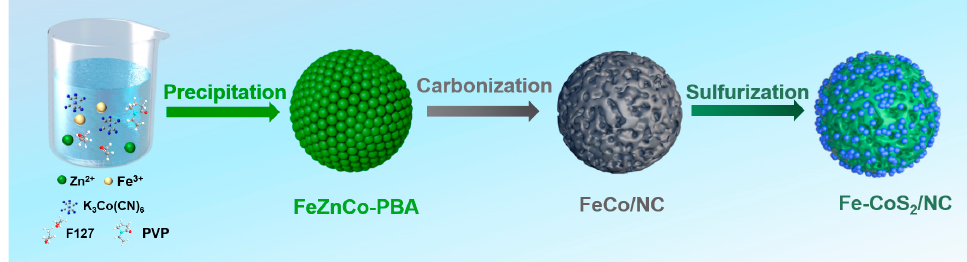
Figure 1. Schematic diagram of the fabrication process for the Fe-CoS 2 /NC spheres.